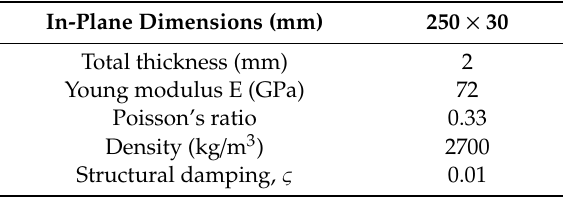
Table 4. Beam mechanical properties (Al 7075 T6).